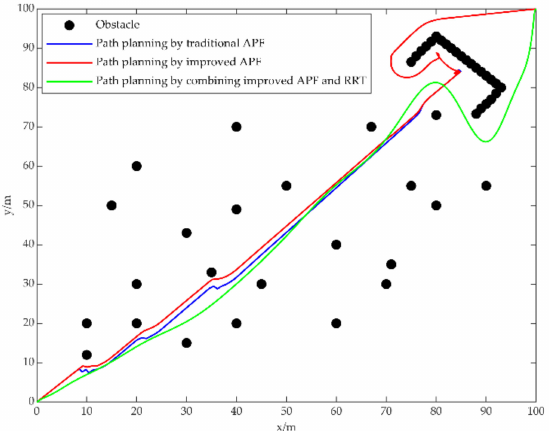
Figure 10. The path planned by the three methods.